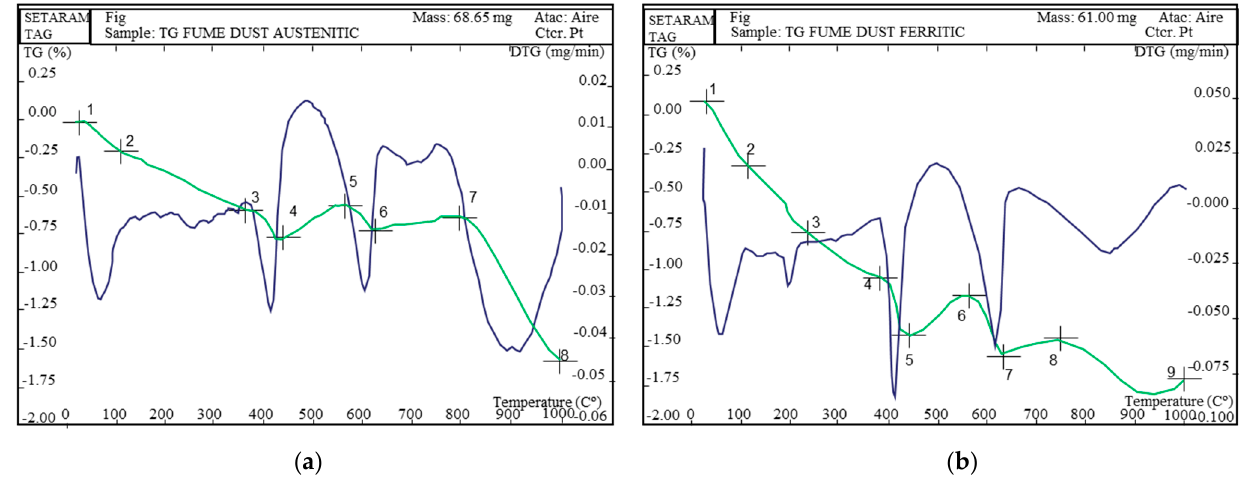
Figure 3. Thermogravimetry of austenitic ( a ) and ferritic ( b ) fume dust.